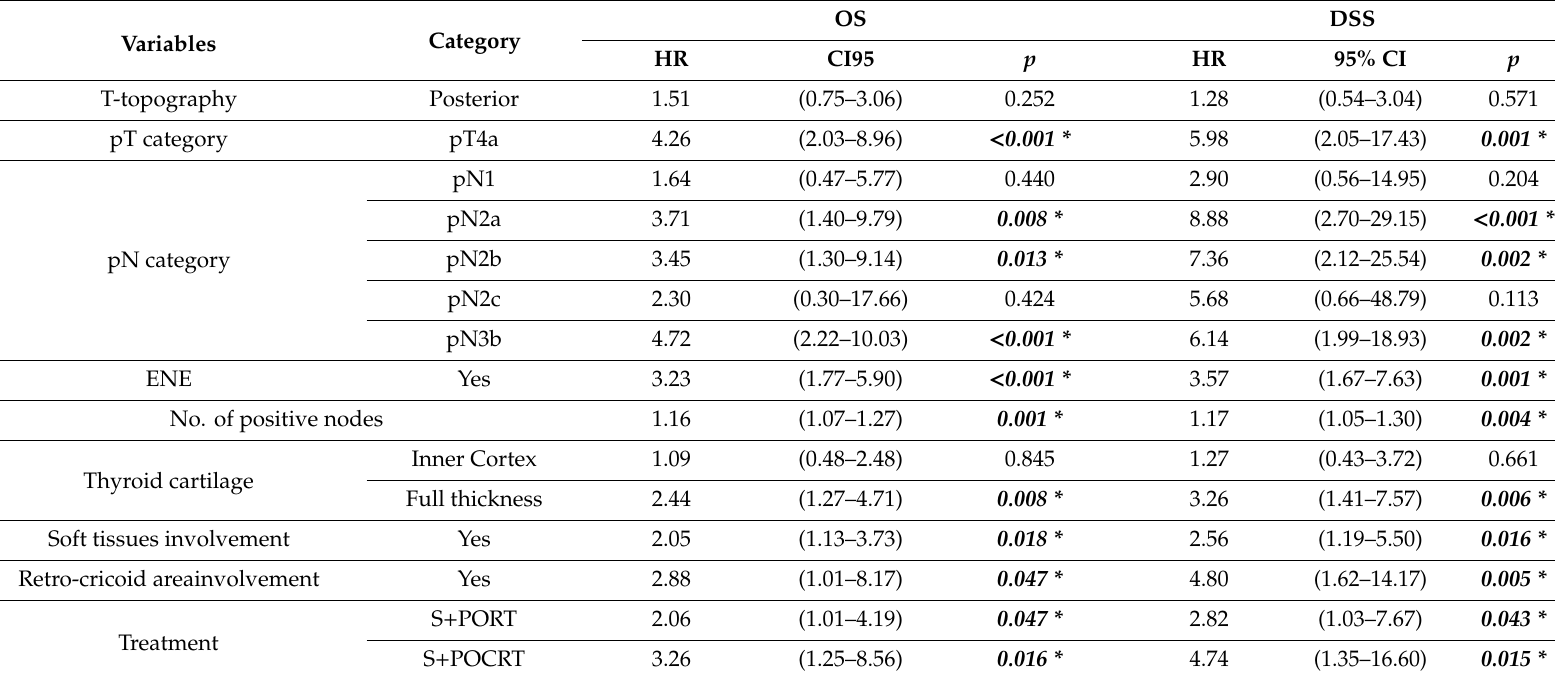
Table 2. Univariable overall (OS) and disease specific survival (DSS) analysis (significant variables for at least one outcome are reported, while additional variables analyzed are reported in Table